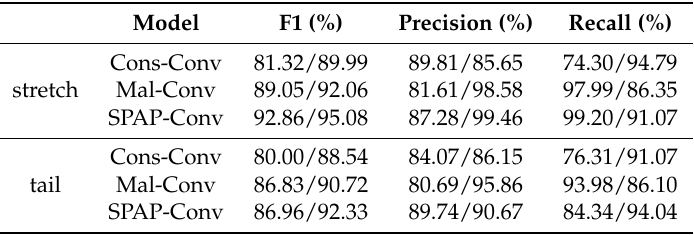
Table 4. Experimental results about effectiveness, where the two values b / m of each cell correspond to benign and malicious cases, respectively.